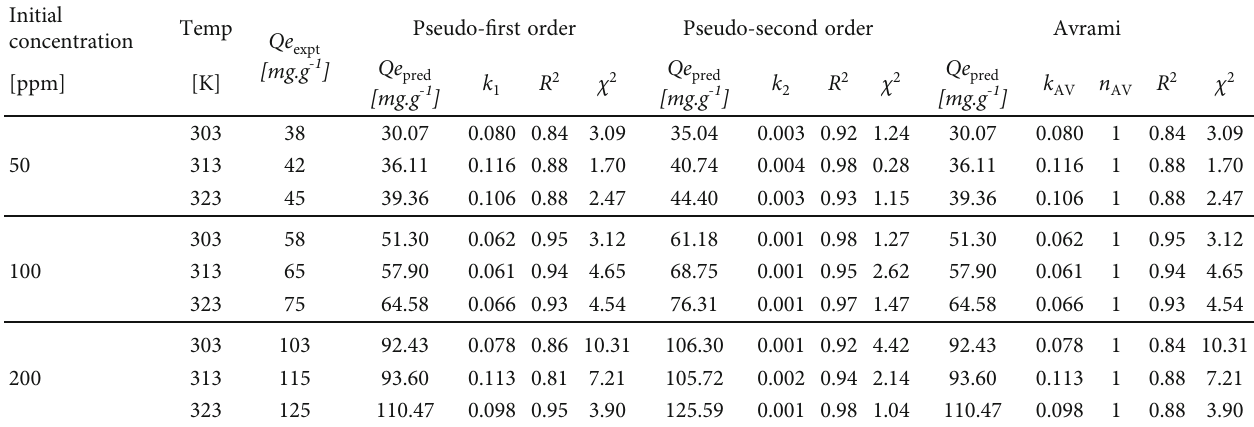
Table 8: Adsorption kinetic model parameters from experimental and theoretical studies.